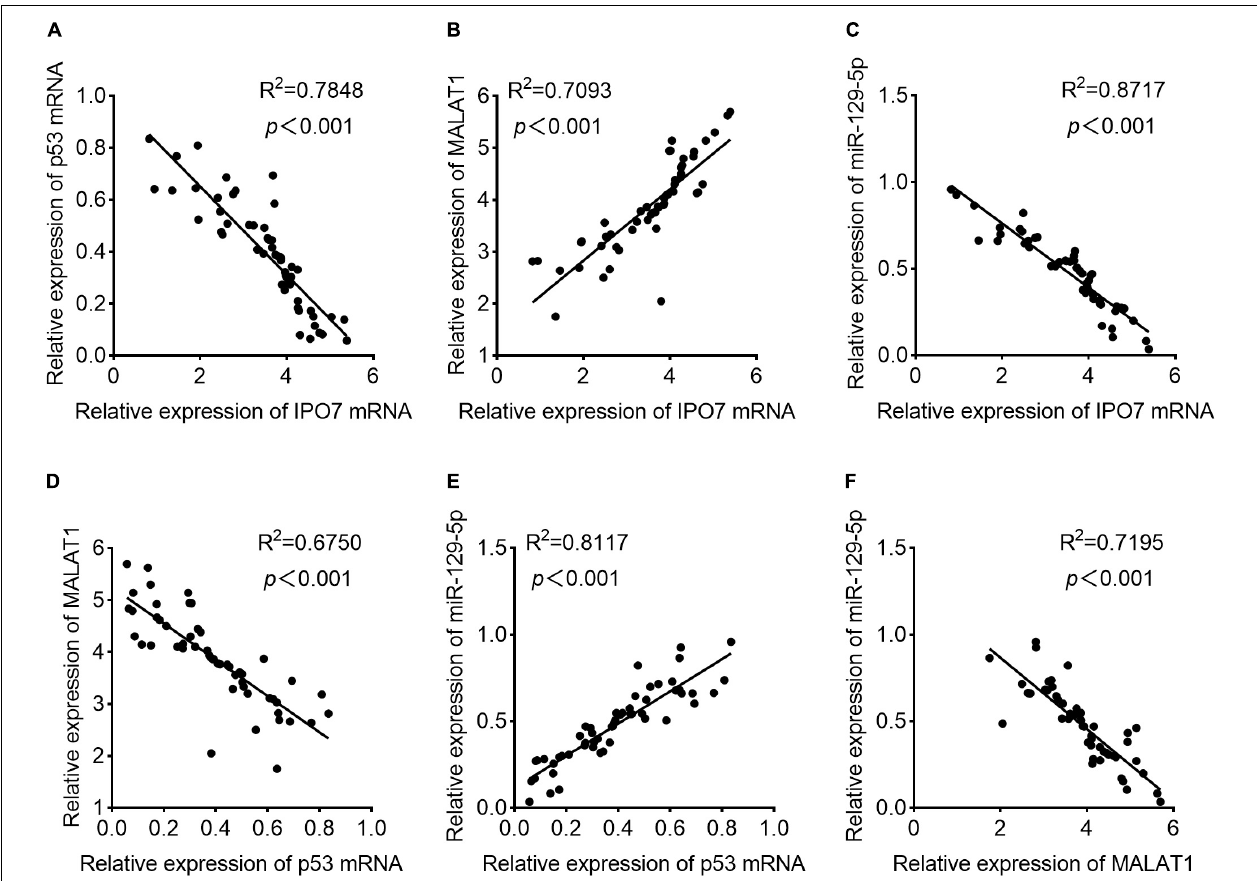
FIGURE 8 | The correlations among the expression levels of importin 7 (IPO7), p53, metastasis-associated lung adenocarcinoma transcript 1 (MALAT1), and miR-129-5p in pancreatic cancer tissues. (A) The expression level of IPO7 mRNA was negatively correlated with that of p53 mRNA. (B) The expression level of IPO7 mRNA was positively correlated with the expression level of MALAT1. (C) The expression level of IPO7 mRNA was negatively correlated with the expression level of miR-129-5p. (D) The expression level of p53 mRNA was negatively correlated with that of MALAT1. (E) The expression level of p53 mRNA was positively correlated with the expression level of miR-129-5p. (F) The expression level of MALAT1 was negatively correlated with the expression level of